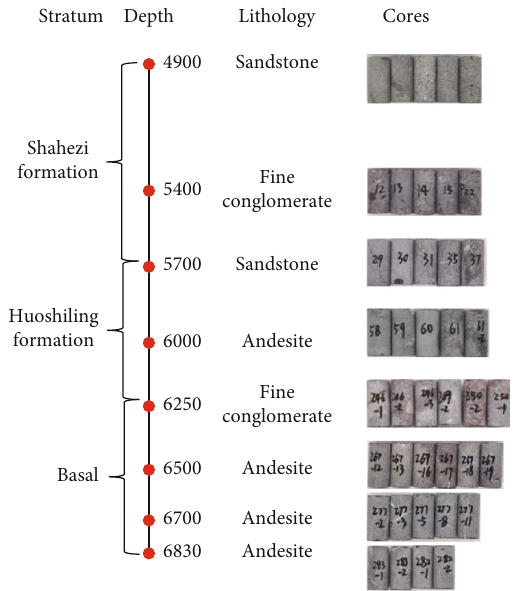
Figure 3: Basic information of deep cores at di ff erent